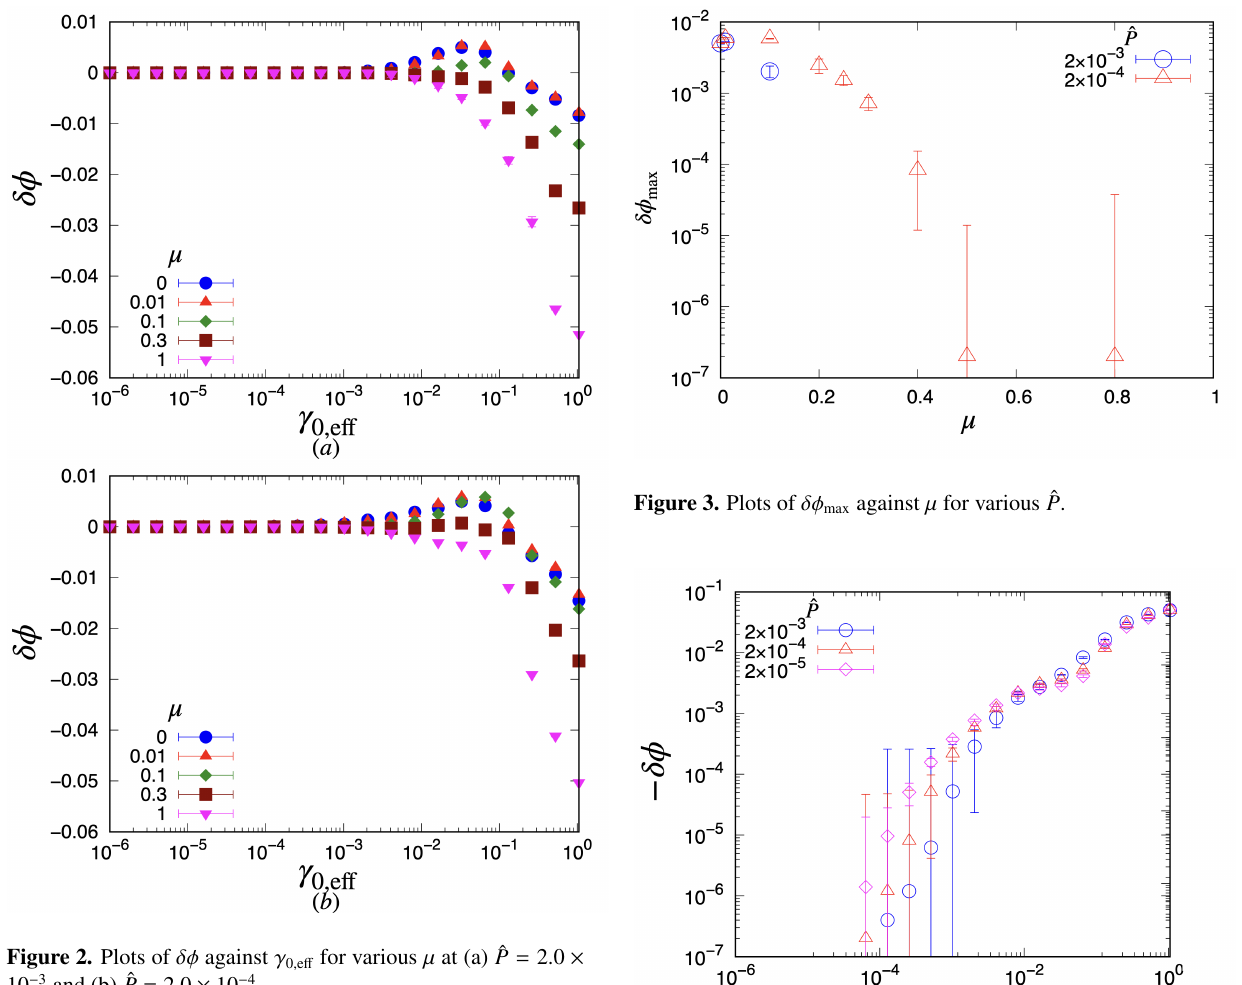
Figure 2. Plots of (cid:14)ϕ against (cid:13) 0 ; e ff for various (cid:22) at (a) ˆ P = 2 : 0 (cid:2) 10 (cid:0) 3 and (b) ˆ P = 2 : 0 (cid:2) 10 (cid:0) 4 .